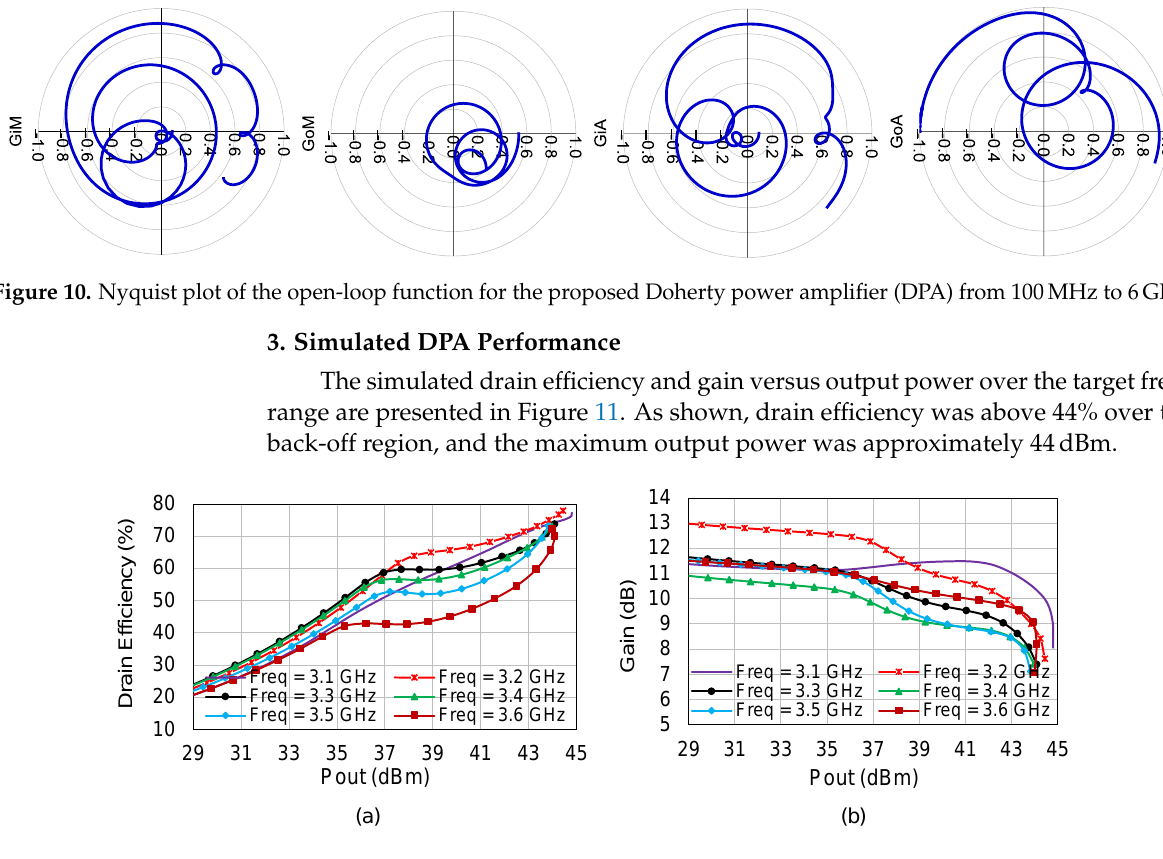
Figure 11. Simulated drain efficiency ( a ) and gain ( b ) of the designed DPA versus output